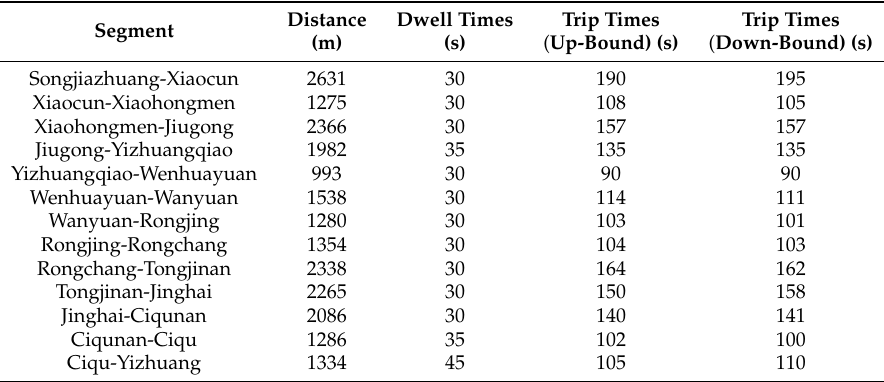
Table 2. Operation situation of the Yizhuang metro